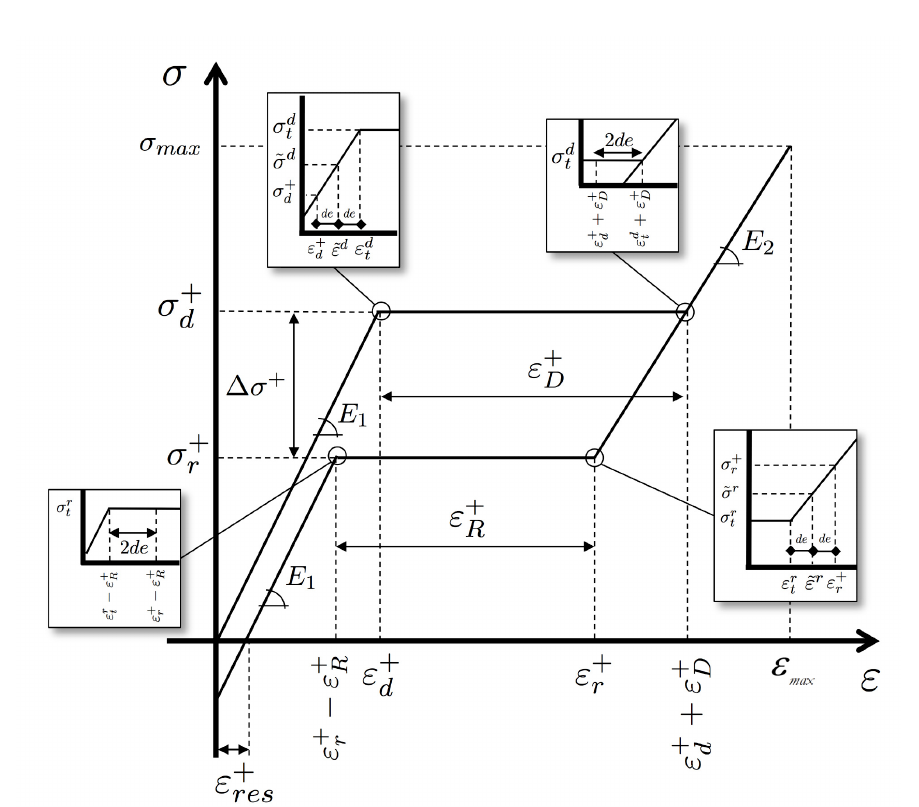
Figure 3: Stress  vs. strain  predicted by present model in a displacement-driven traction loading-unloading test at the high > T temperature 2 af